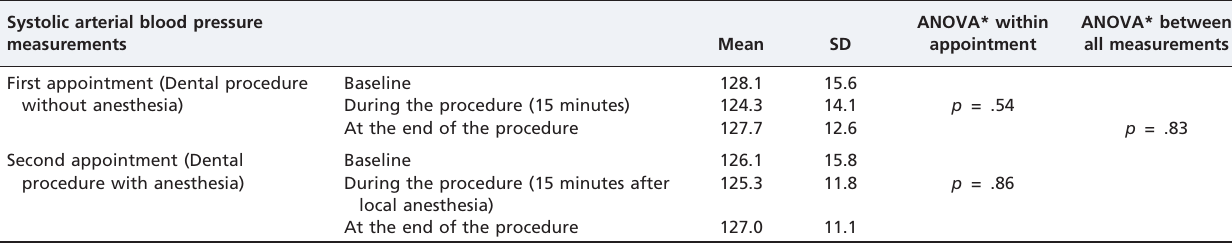
Table 2 - Mean, standard deviation (SD), and results of statistical analyses of six systolic arterial blood pressure measurements taken during two different appointments for dental treatment with and without LAVA (2% mepivacaine with adrenaline 1100,000) (n= 37).